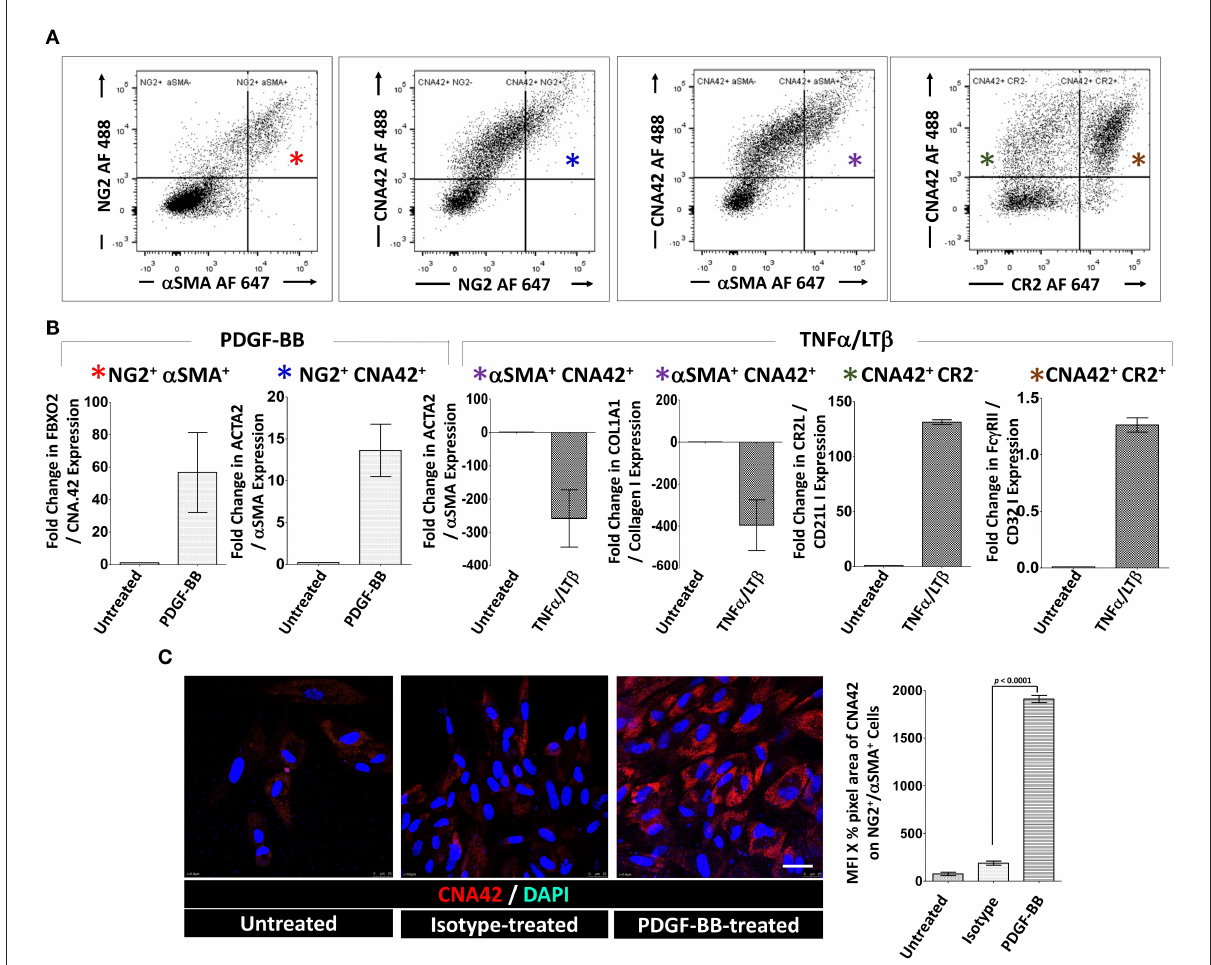
FIGURE4 Activation of sorted tonsillar stromal cell subsets with PDGF-BB and TNF- α /LT- β induces early and mature FDC markers in vitro . (A) The CD45 − tonsillar stromal subsets were sorted using combinations of NG2/ α SMA, NG2/CNA.42, CNA.42/ α SMA and CNA.42/CR2 Abs. (B) Type-1 Pericytes [NG2 + / α SMA + ; indicated by red * in (A,B) ], early FDCs; (CNA.42 + /NG2 + , CNA.42 + / α SMA + , CNA.42 + /CR2 − ; indicated in A and B by blue, magenta, and green *, respectively) and mature FDCs [CNA.42 + /CR2 + , indicated by brown * in (A,B) ] were treated with 300ng/ml PDGF-BB or 100ng/ml TNF- α + 100ng/ml LT- αβ and the fold change in FBXO2 (CNA.42), α SMA, Collagen 1, CR2, and Fc γ RIIB gene expression compared to untreated cells was calculated by Livak’s DD equation and shown in bar graphs. (C) Treatment of the NG2 + / α SMA + type-1 pericyte subset with PDGF-BB in slide cultures for 6 days induced the expression of the FDC marker CNA.42 compared to untreated cells as demonstrated by Immunocytochemistry. Image J quantification of the mean fluorescence intensity (MFI) of CNA-42 of the different conditions is shown in the histogram. Data is representative of three different experiments and is expressed as the mean ±